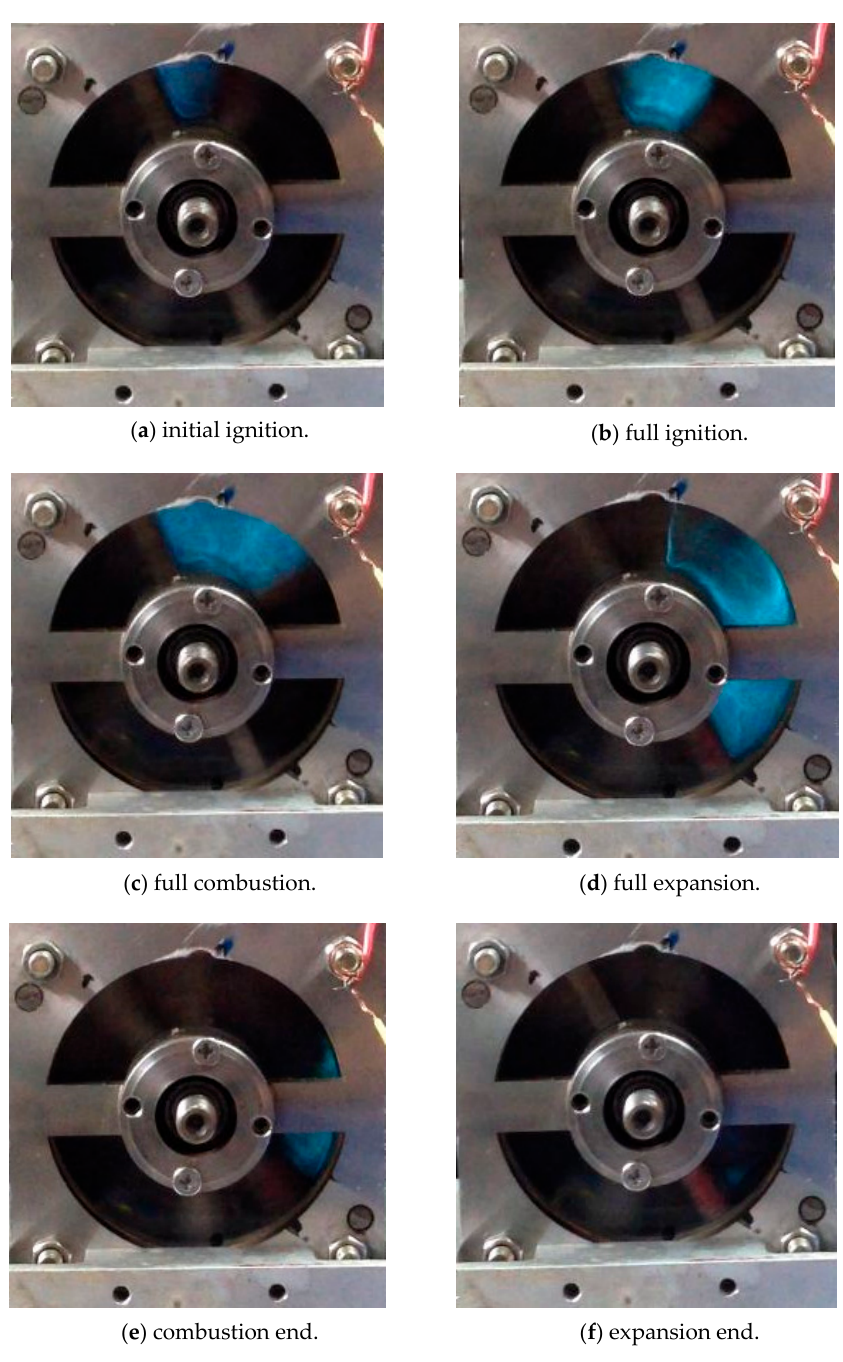
Figure 31. Combustion process for one chamber.